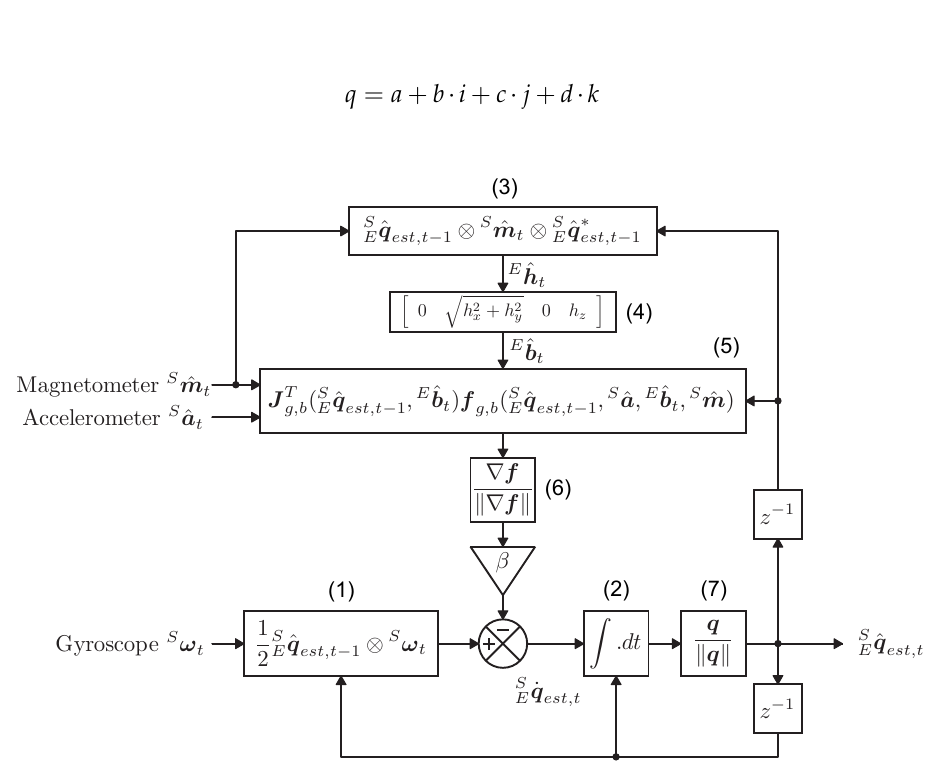
Figure 2. Block diagram Madgwick algorithm [11]. Fig. 2. Block diagram representation of the complete orientation estima- tion algorithm for an MARG implementation including magnetic distortion compensation